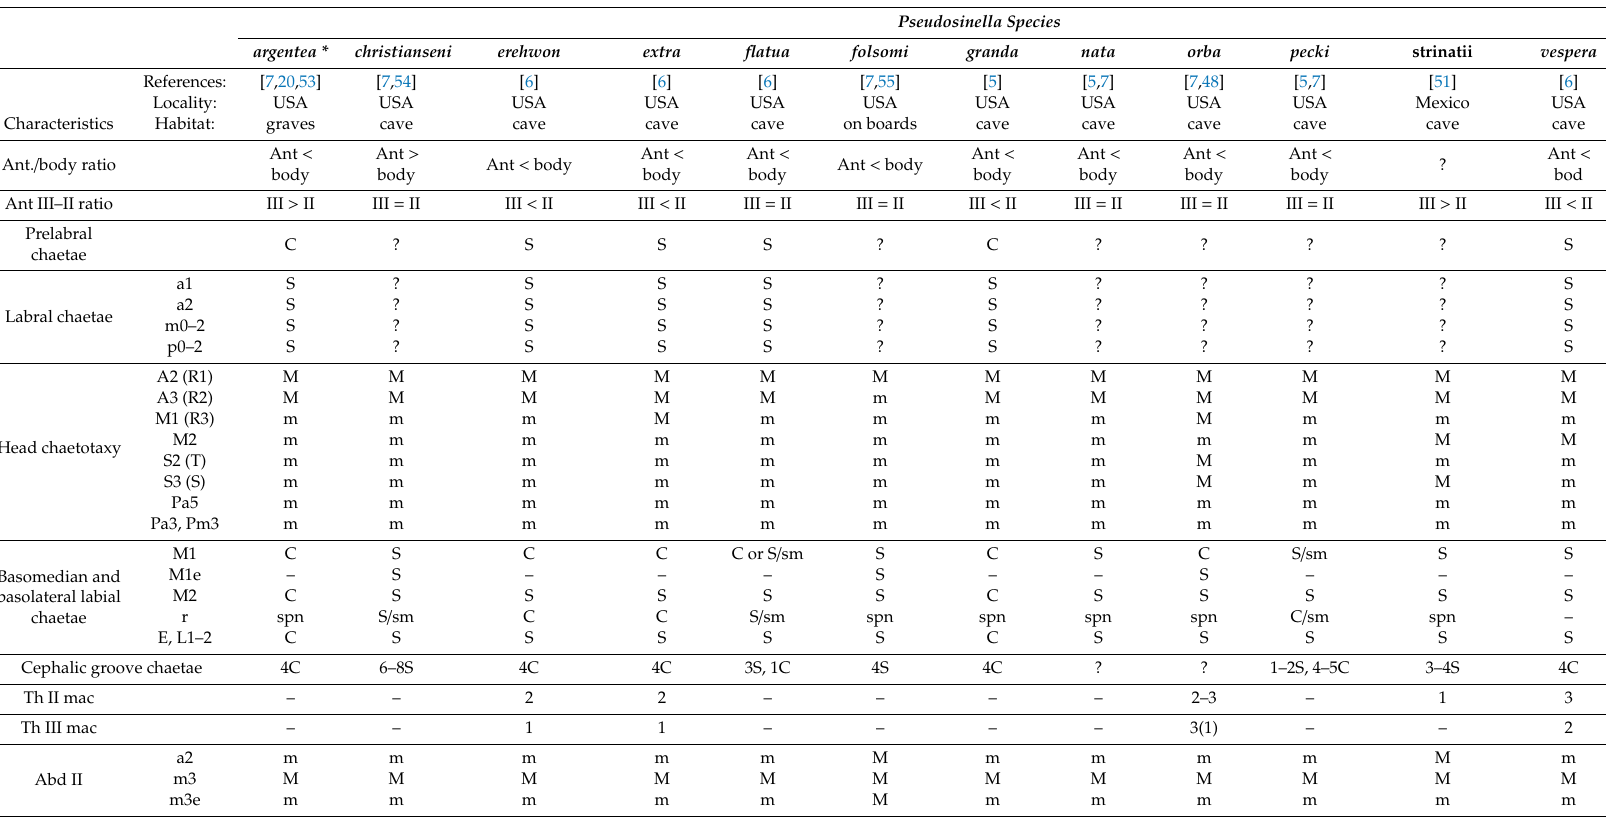
Pseudosinella Species